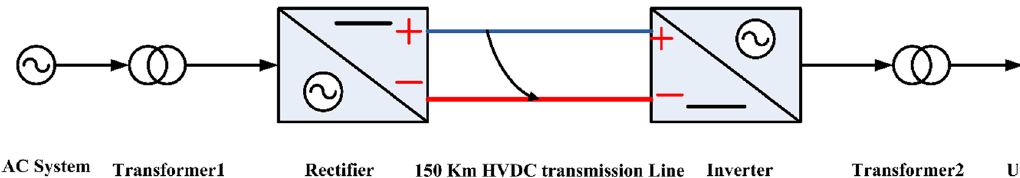
Fig. 4 Short circuit fault between positive and negative (PN) on an HVDC system